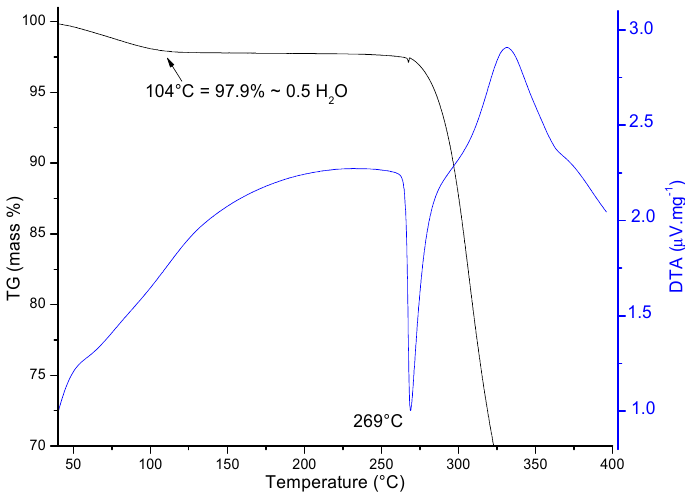
Figure 8. TG (in black) and DTA (in blue) curves measured from 40 to 400 °C starting with ORBI hemihydrate. The arrow shows the temperature of the complete water loss from the structure.